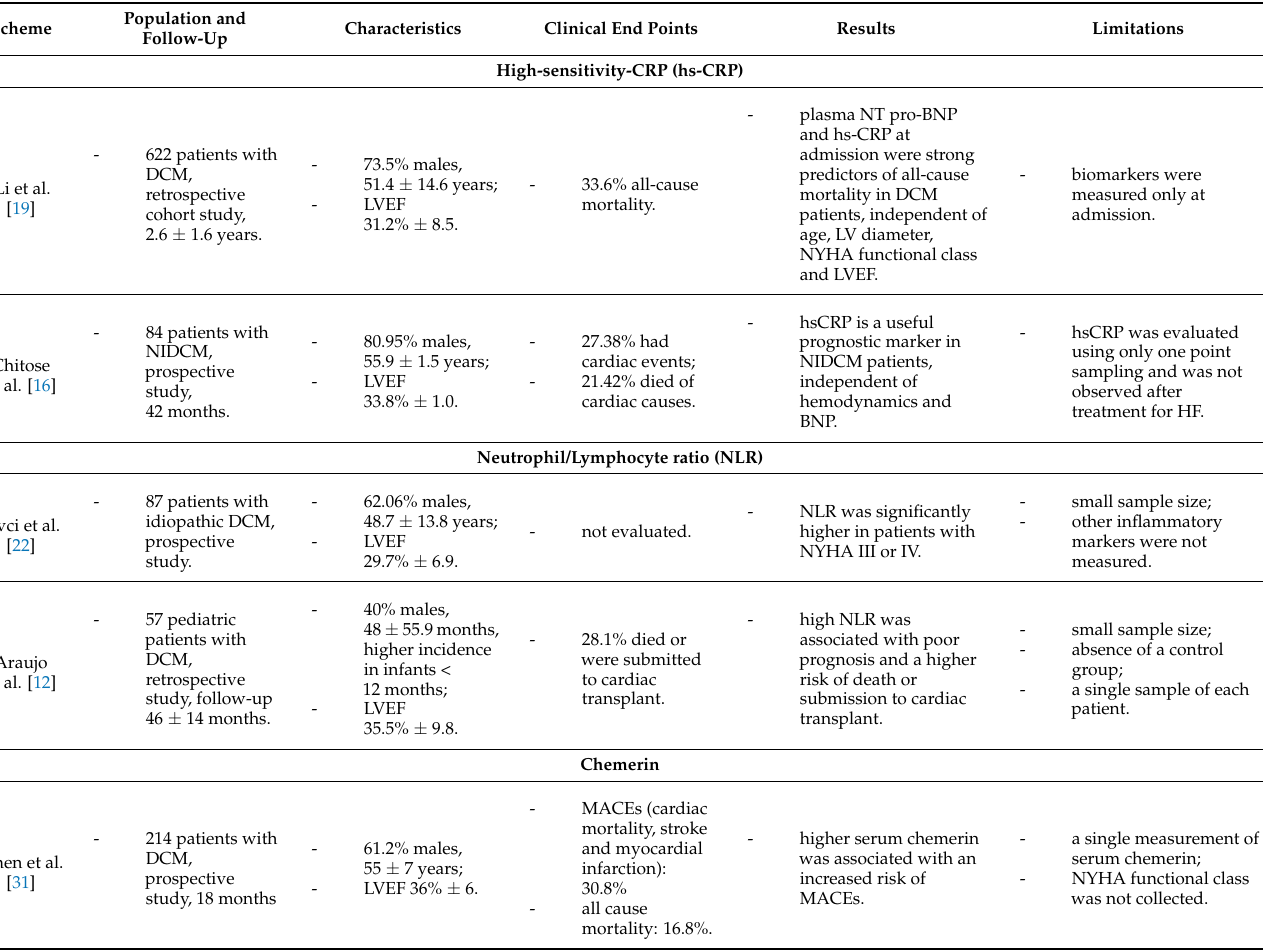
Table 2. Studies related to novel possible biomarkers for risk stratification in dilated cardiomyopathy.